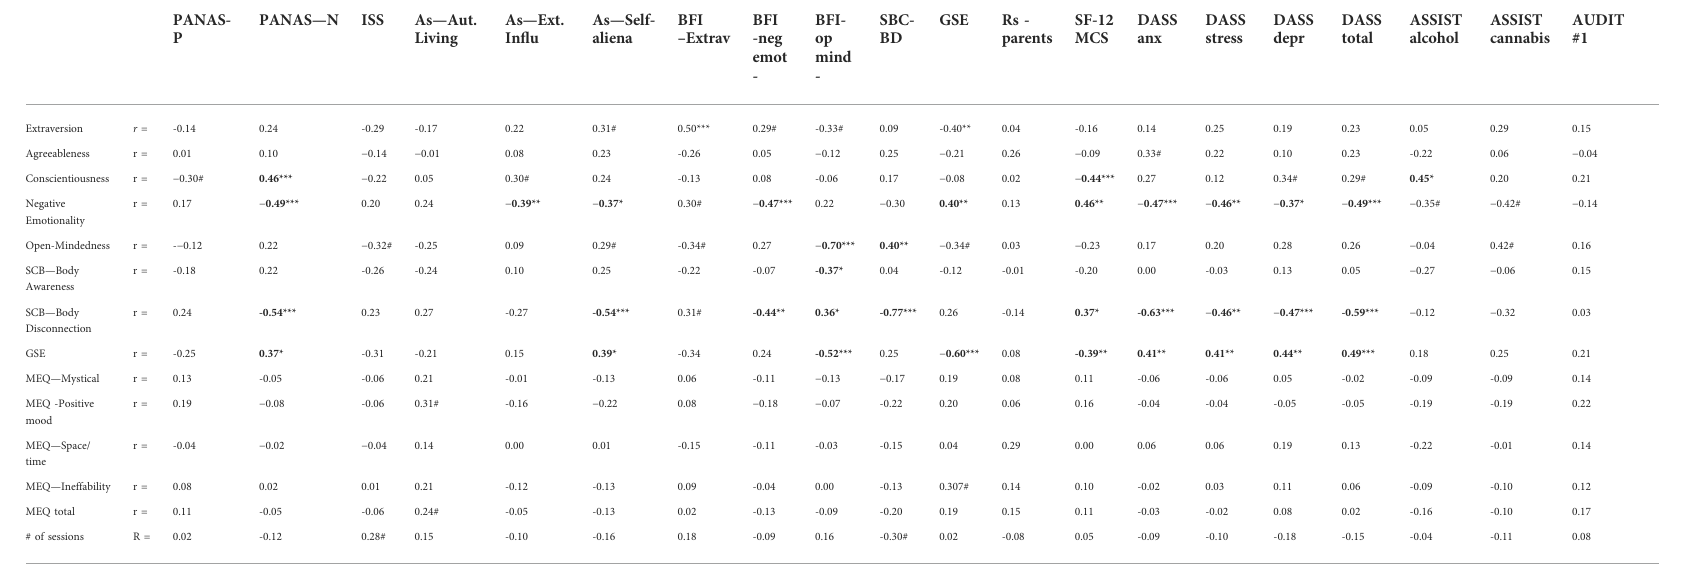
TABLE 4 Pearson ’ s correlations between baseline traits or MEQ facets and 1-month behavioural change scores. Change scores at 1-month PANAS- PANAS — N ISS As — Aut. As — Ext. P Living In fl u